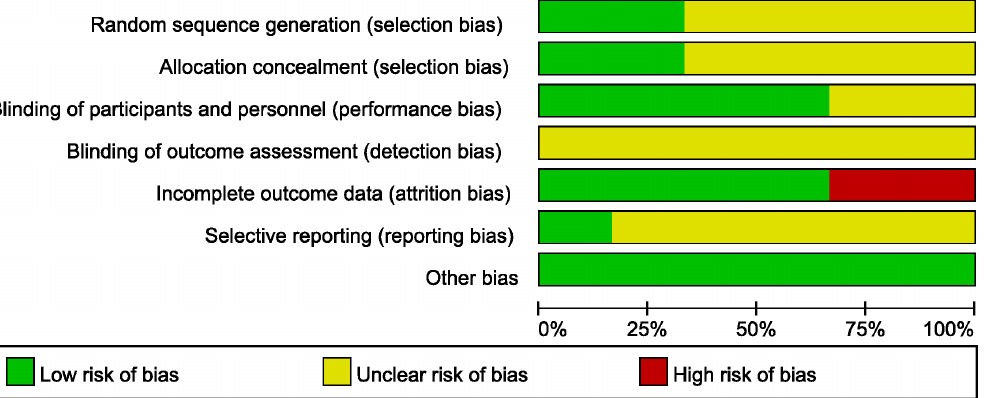
Figure 2. Graph of the risk of bias for the included studies. This graph is based on the results of domain-based evaluation according to the criteria of the Cochrane Handbook for Systematic Reviews of